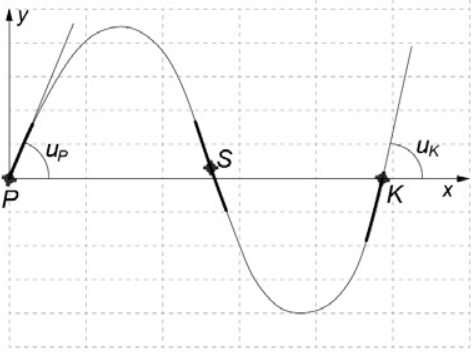
Figure 3. Sections of the S -shaped transition curve with minimal values of